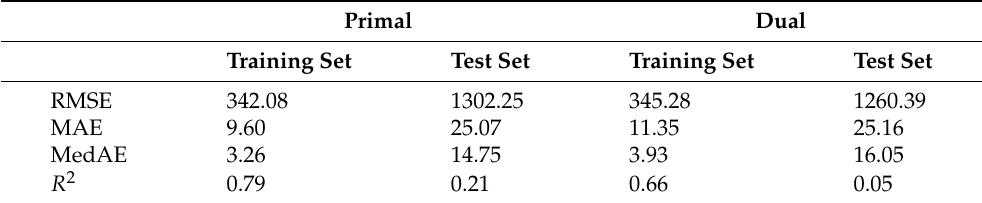
Table 4. MLPRegressor model for the execution time of the primal and dual simplex